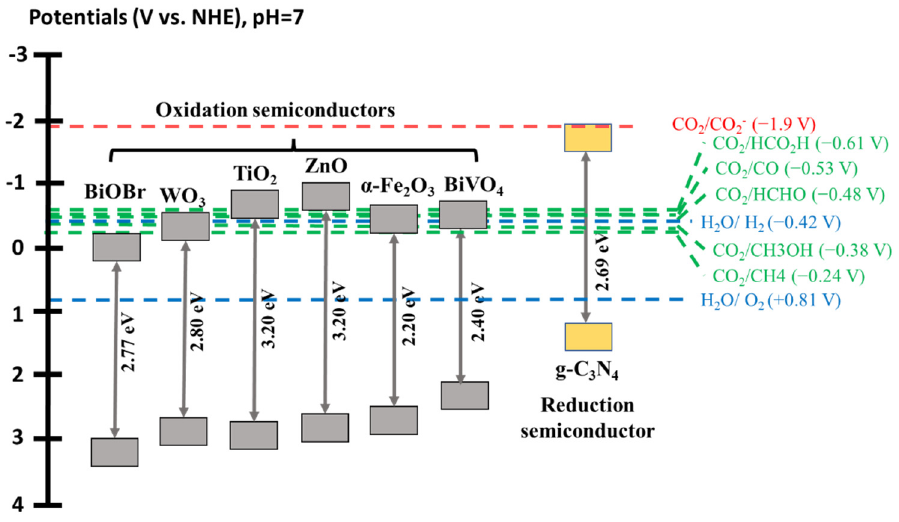
Figure 5. Band structure of g -C 3 N 4 and some oxidation semiconductors. Adapted from [37]. Copy- right 2021, Elsevier.